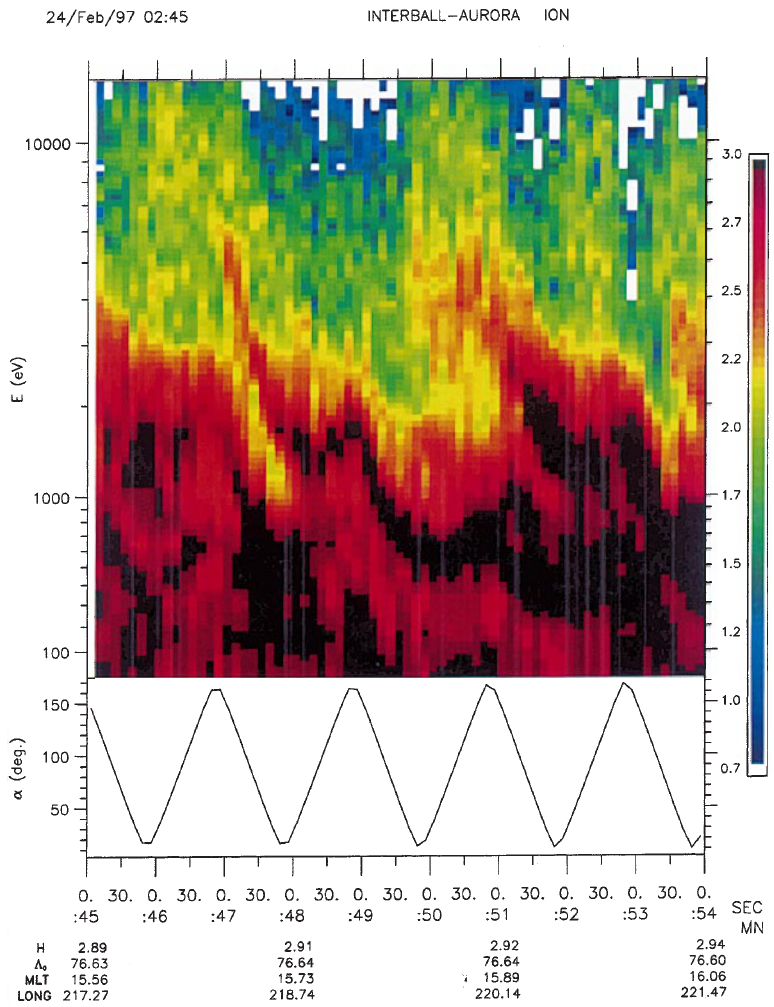
Fig. 8. Detail of Fig. 7. Energy-time spectrogram of protons between 02:45 and 02:54 UT on 24 February 1997. At the bottom, the pitch-angle of the ions. Note the serpentine structure starting around 02:47 UT and the two maxima seen between 02:50:30 and